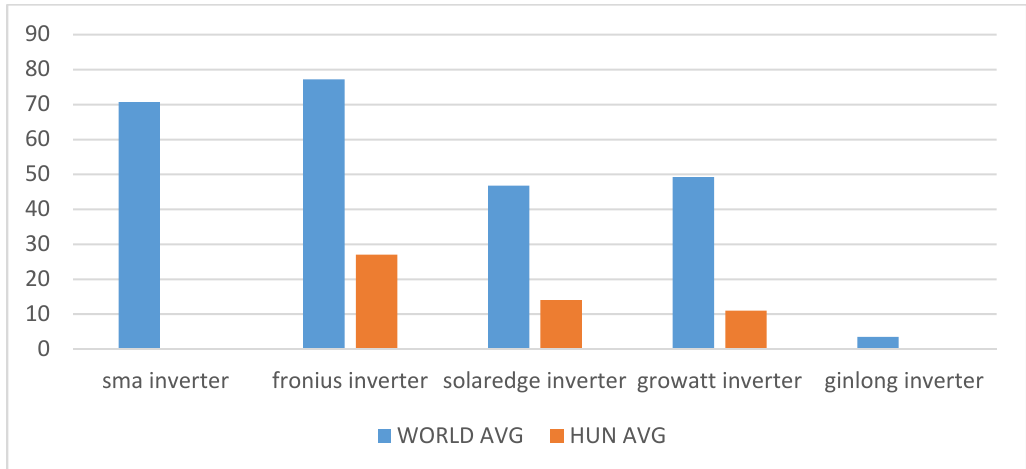
Figure 6. The average weekly number of global and Hungarian searches.